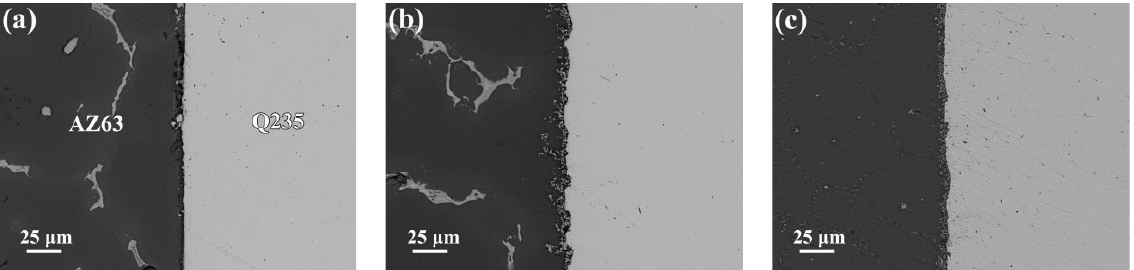
Figure 6. BSE micrographs of the interfacial of ( a ) AZ63/Q235, ( b ) AZ63/galvanized Q235, and ( c ) AZ63/galvanized Q235 + T6.